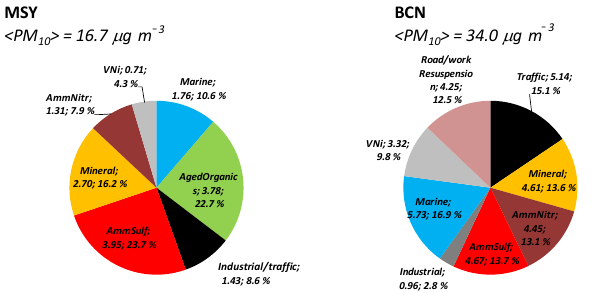
Figure 5. Source contributions from PMF model in PM 10 at Montseny (MSY) and Barcelona (BCN). Mean values during 2004– 2014. Values reported are sources in µgm − 3 and